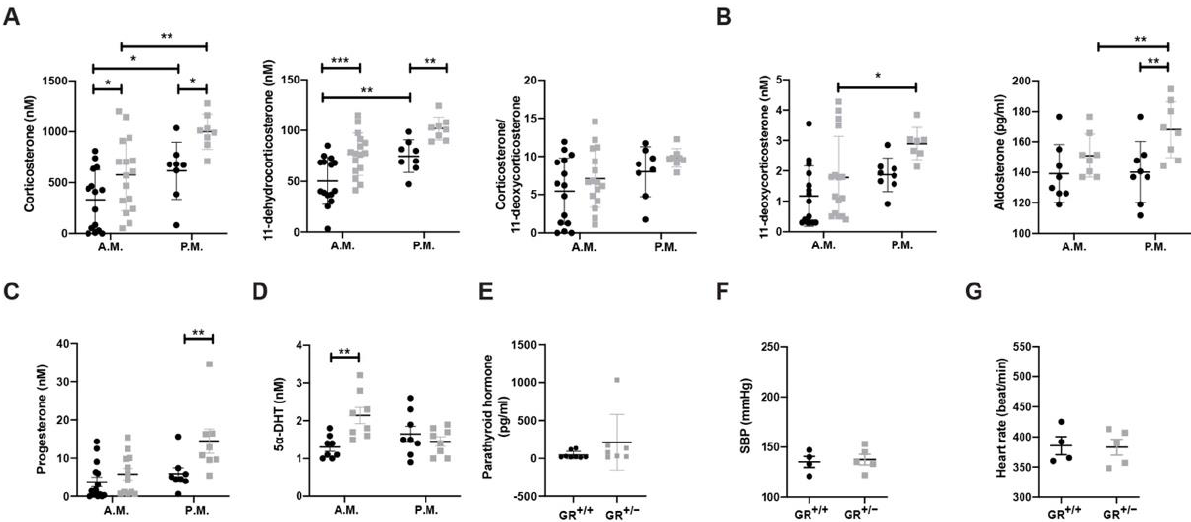
Figure 1. GR +/ − rats developed steroid disturbances. Plasma concentrations of ( A ) glucocorticoids, including corticosterone, 11-dehydrocorticosterone, and the corticosterone/11-dehydrocorticosterone ratio, ( B ) mineralocorticoids, including 11-deoxycorticosterone and aldosterone, ( C ) progesterone and ( D ) 5 α -DHT during morning (7–8 a.m.) and evening (6–7 p.m.) from 3–4 weeks old male GR +/+ (n = 15 − 16) or GR +/ − (n = 8) rats. ( E ) Plasma concentration of parathyroid hormone from 3–4-week-old male GR +/+ (n = 15 − 16) or GR +/ − (n = 8) rats. ( F ) Systolic blood pressure and ( G ) heart rate of 3–4-week-old male GR +/+ (n = 4) or GR +/ − (n = 5) rats in standard diet (StD). Values are indicated as mean ± SEM, and data were evaluated by two-way ANOVA and compared with Fisher’s LSD test or unpaired two-tailed t test, and differences were assessed at * p < 0.05; ** p < 0.01; *** p <